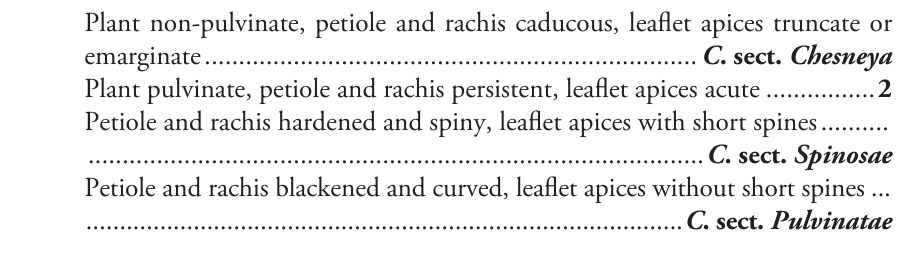
Fig. 3C Type. Chesneya spinosa P.C.Li, Acta Phytotax. Sin. 19(2): 236. 1981. Description, distribution and habitat. This monotypic section is recognized by its hardened-spiny petiole and rachis. It is restricted in high-altitude psychrophytic rocky slope in southern